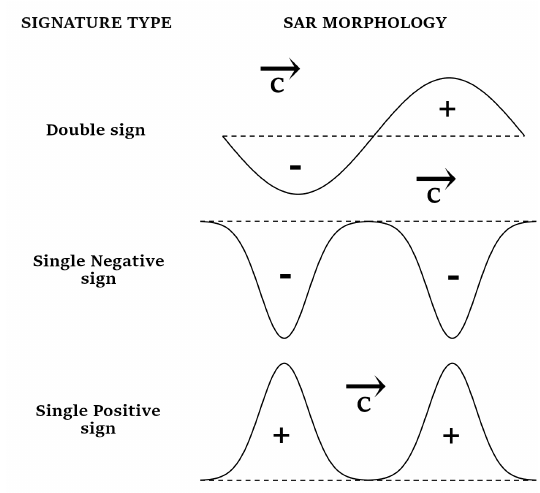
Figure 4. Scheme representing the IW signature type and the its SAR morphology. The dashed black line represents a homogeneous sea surface background. The IW phase velocity is represented by the C